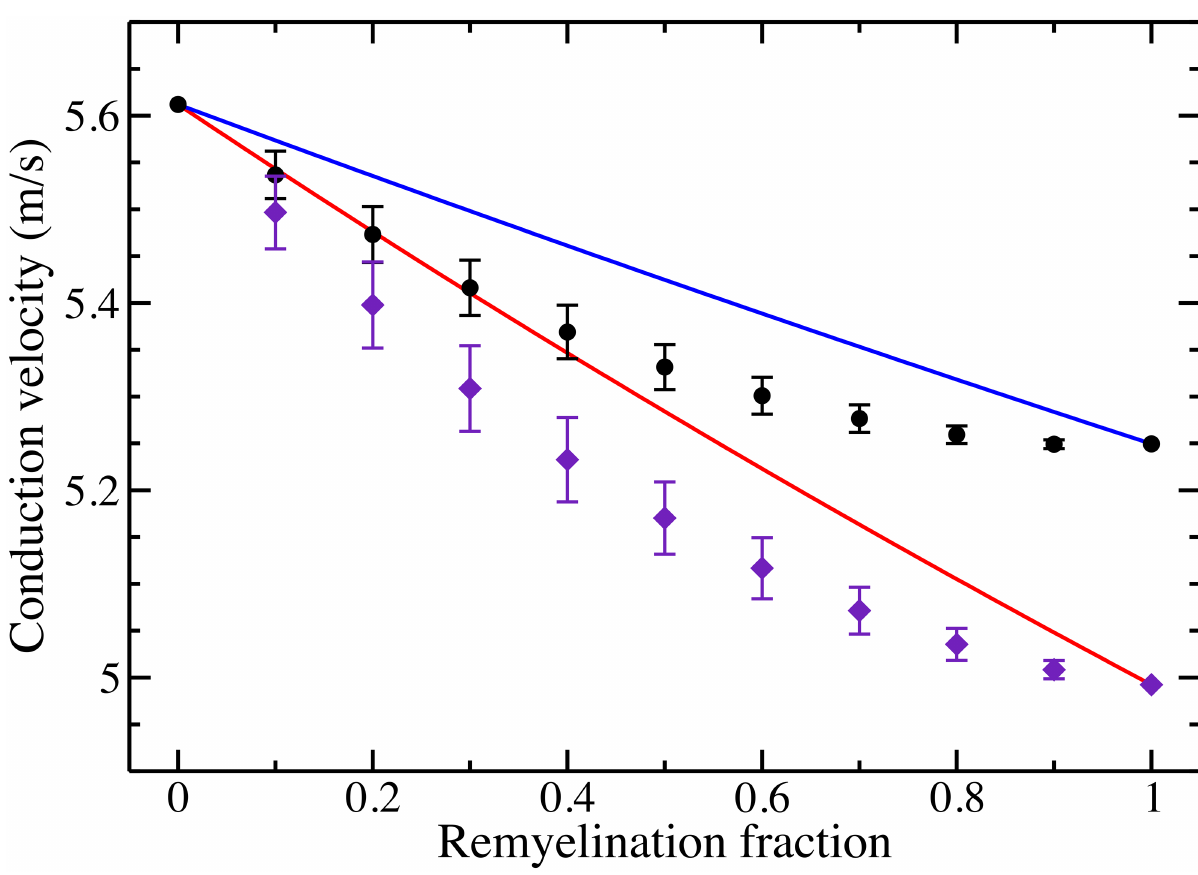
Fig 2. Conduction velocity along progressively remyelinated axons for the Gow and Devaux TJ model. The black circles represent the average CV (and standard deviation) for 500 model neurons with a given fraction of remyelinated segments with a g -ratio of 0.69; the blue solid curve is the benchmark velocity (cid:22) v ð p Þ for this case. The purple diamonds represent the average CV (and standard deviation) for 500 model neurons with a given fraction of remyelinated segments whose g -ratio is 0.86; the red solid curve is the benchmark velocity (cid:22) v ð p Þ for this case.